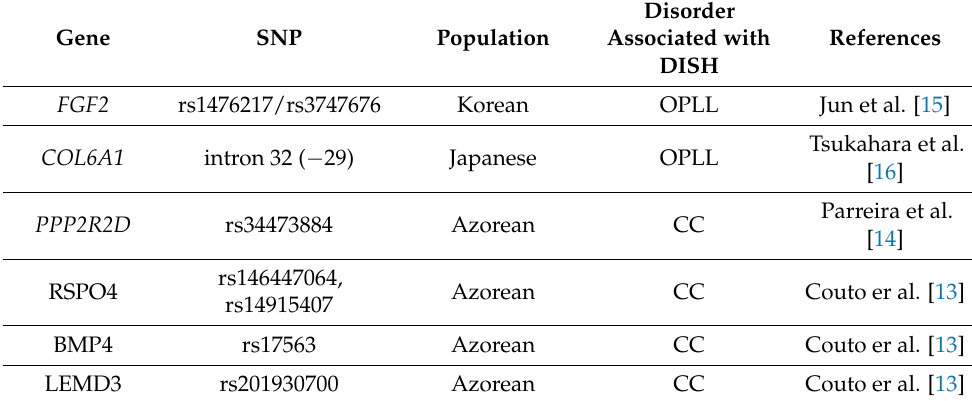
SNP, single nucleotide polymorphism; OPLL, ossification of the posterior longitudinal ligament; CC, chondrocalcinosis.